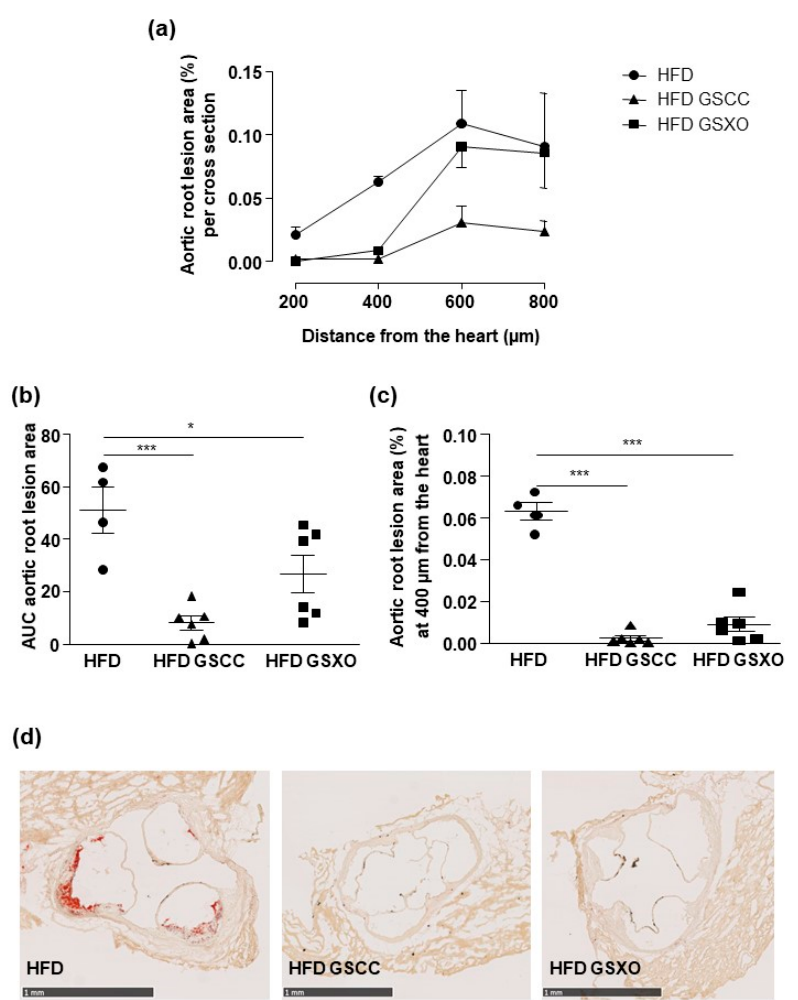
Figure 5. Effect of diet and apple supplementation on atherosclerotic lesions of ApoE-/- mice . Extent of atherosclerosis in the aortic root per cross section ( a ), quantification of AUC of aortic root area ( b ), atheroma area at 400 µm from the heart ( c ), and representative images (scale bar 1mm) of stained aorta ( d ) from mice receiving standard diet (SD), high fat diet (HFD), and HFD supplemented with apple for 14 weeks. The data were expressed as the mean ± SEM. * p < 0.05, *** p < 0.001.